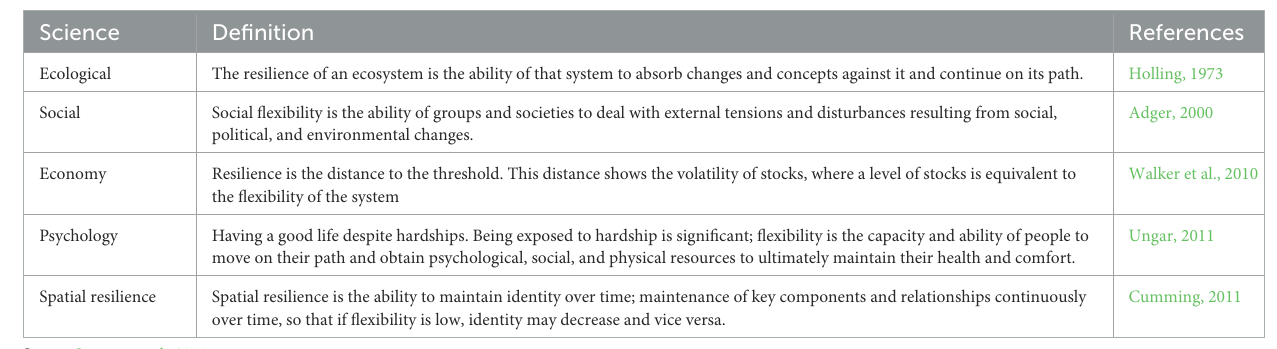
TABLE 1 Definitions and concepts of resilience in different scientific